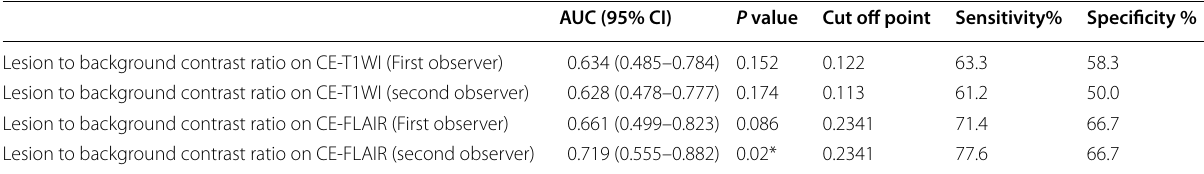
Table 5 Demonstrate sensitivity and specificity of lesion to background contrast ratio on CE‑FLAIR and CE‑T1WI by both observers